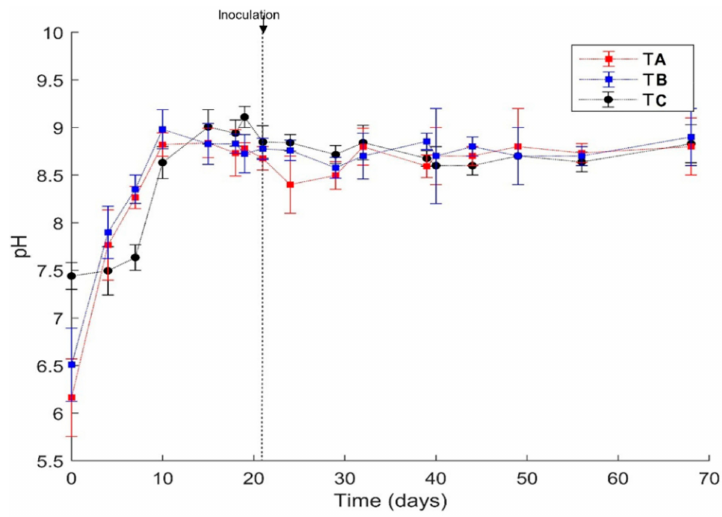
Figure 2. pH changes during the composting